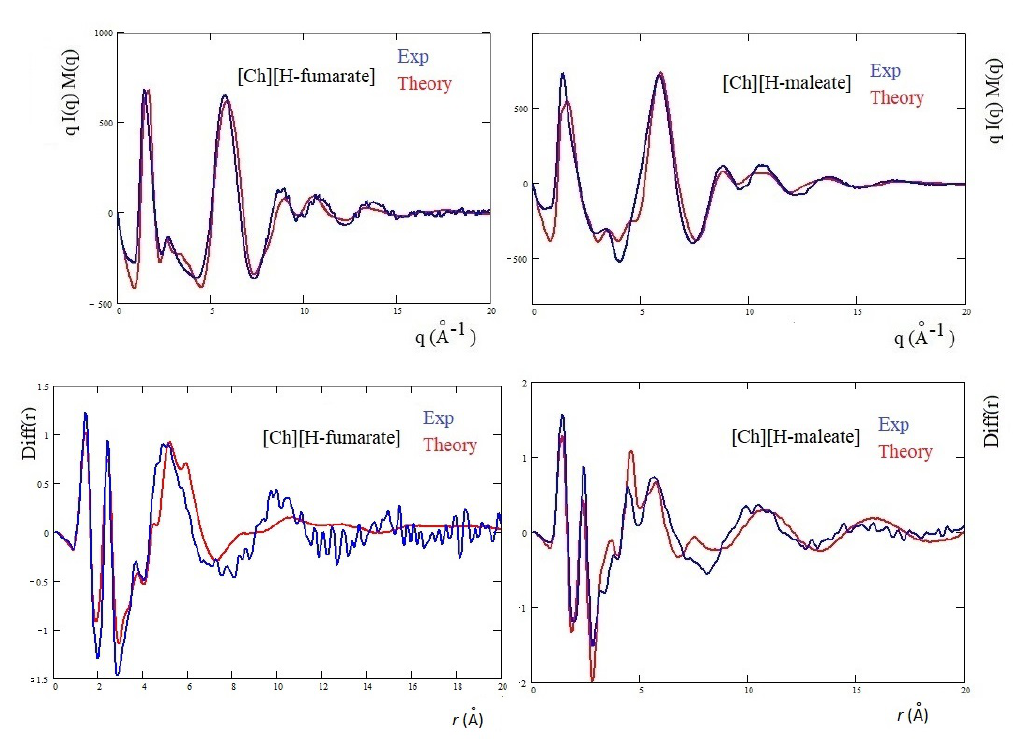
Figure 7. Theoretical qI(q)M(q) and Diff(r) of H-maleate and H-fumarate in comparison with